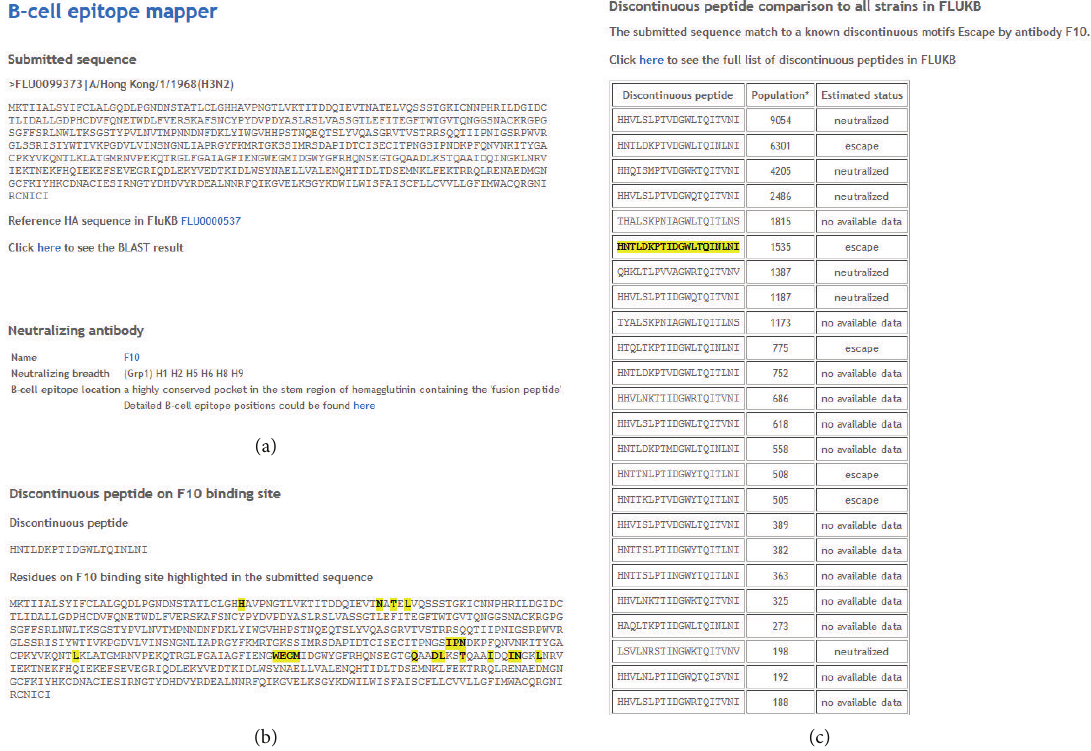
Figure 5: The results of B-cell epitope analysis II. Analysis of entry FLU0099373 for broadly neutralizing antibody F10 interaction. (a) The BLAST result of the query sequence to the sequence with highest identity in FLUKB, (b) the discontinuous peptide extracted from the query sequence and respective residue positions highlighted in full sequence, and (c) the summary information of neutralizing antibody. The discontinuous peptide from the query sequence is compared to all discontinuous peptides generated from FLUKB (with their neutralizing status listed). The identical sequence is highlighted in yellow with estimated status of neutralization